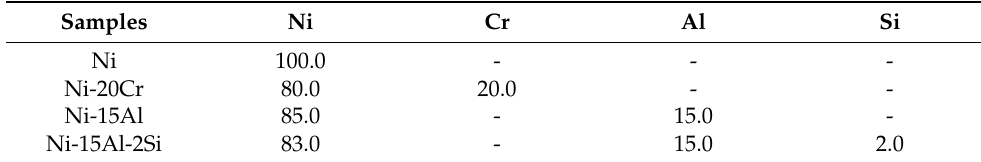
Table 1. Nominal composition of pure Ni and three model alloys (at.%).